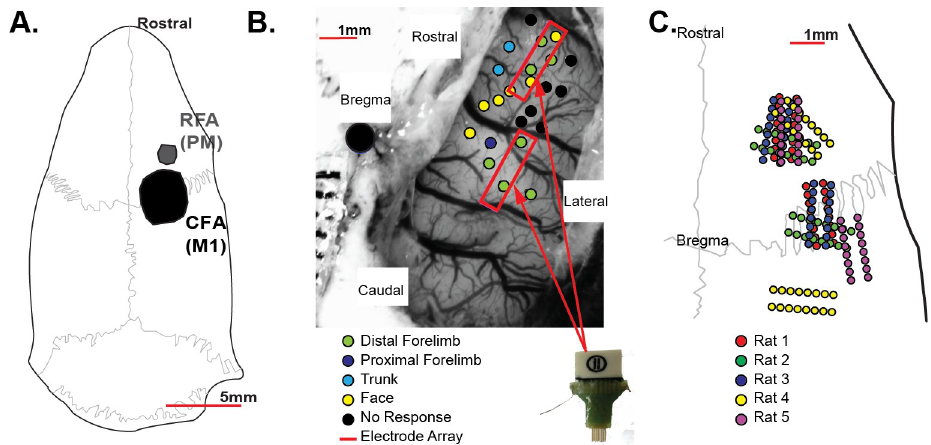
Fig 2. Chronic microelectrode implants. A. The rodent motor system consists of the caudal forelimb area (CFA), a homologue of M1, as well as a secondary rostral forelimb area (RFA), a homologue of premotor cortex. B. Sixteen- channel chronic microwire electrode arrays were implanted into each rat with one array placed in RFA and a second array implanted into CFA. Intracortical microstimulation mapping was used to confirm the locations of RFA and CFA in three rodents with stereotaxic coordinates used to determine implant locations in the remaining rats. C. Approximate implant locations relative to skull landmarks were determined from intraoperative photographs. With respect to stereotaxic coordinates, the location of the electrode arrays implanted into RFA was very consistent across rats with more variability in the locations of the CFA arrays due to the variable locations and orientations of blood vessels relative to the craniectomy